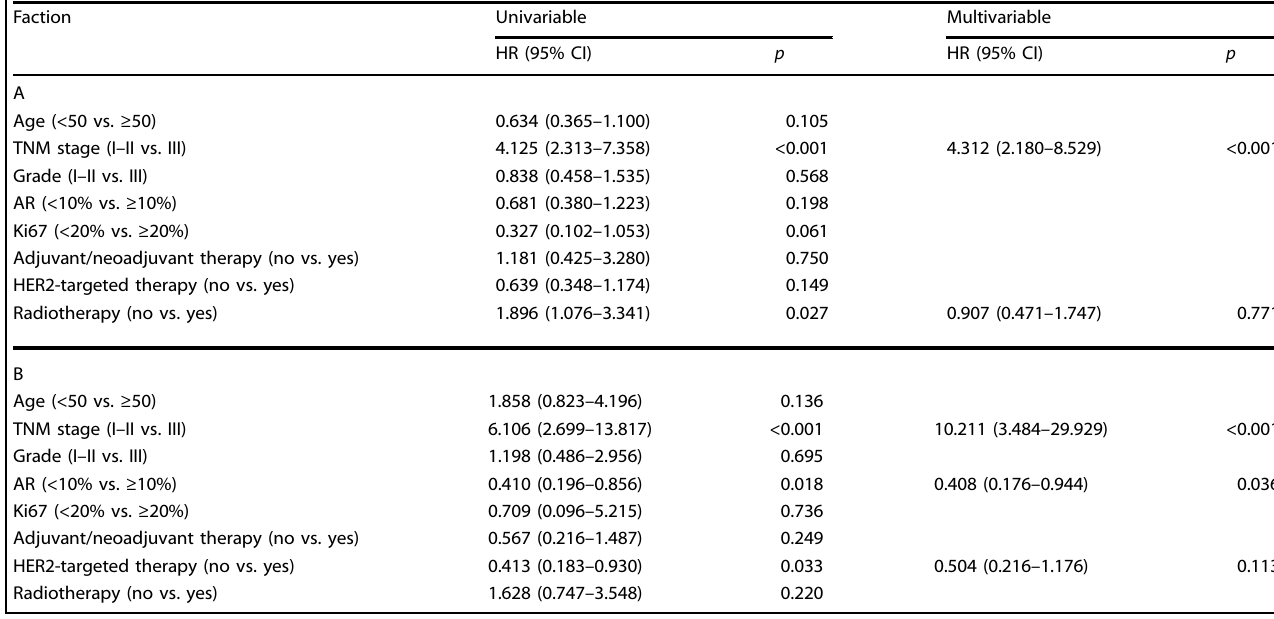
Table 3. Cox proportional hazard regression analysis of DFS (A) and OS (B) in HER2 + HR − breast IDC patients with AR cut-off of 10%.